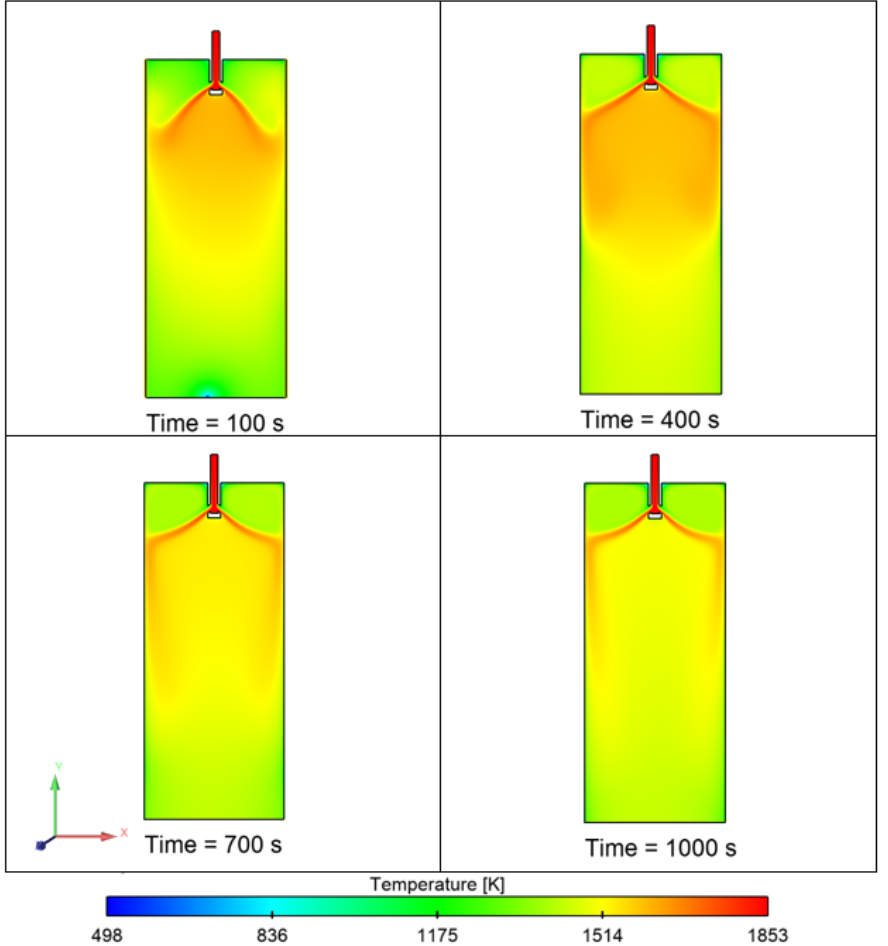
Figure 11. Temperature contour of the mold domain (initial melt temperature: 1853 K).